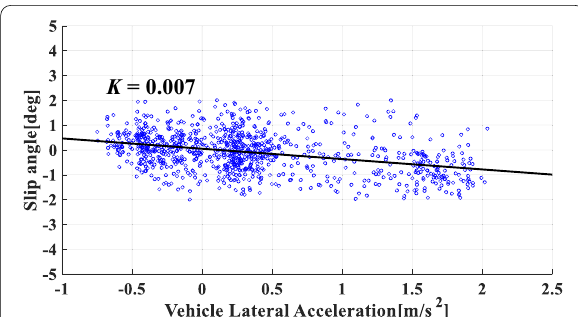
Fig. 7 Relationship between slip angle and lateral acceleration using GNSS/Doppler